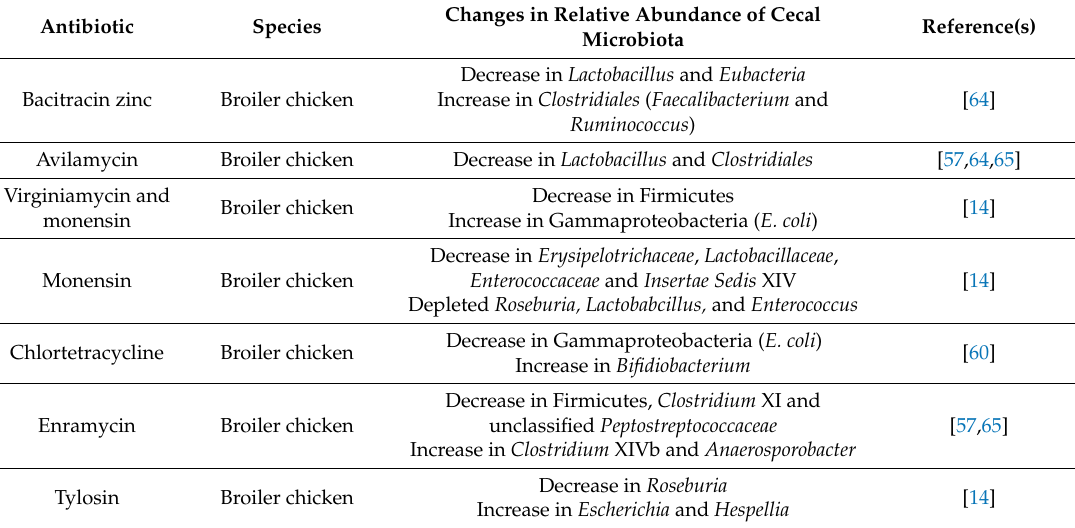
Table 1. Antibiotics used in poultry production, and their impact on the cecal